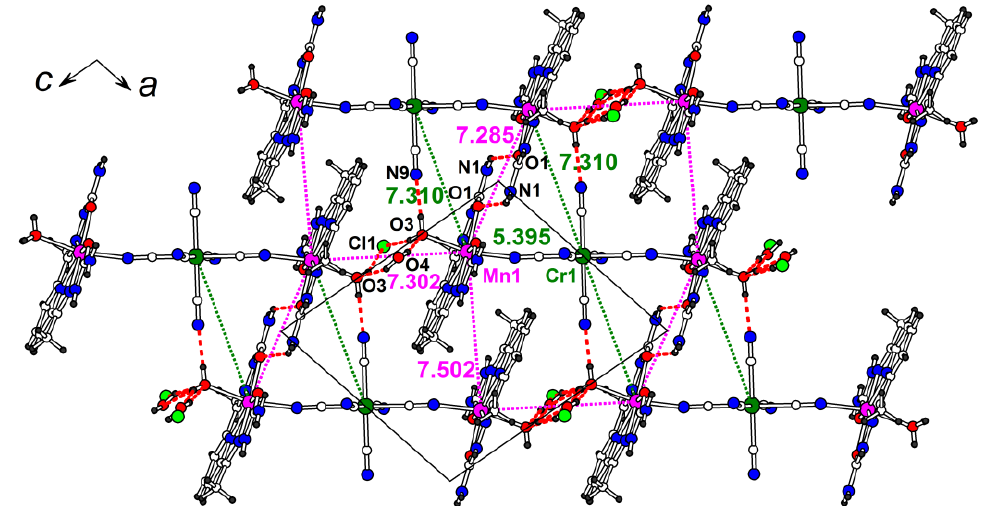
Figure 5. The ac layer in the structure 3 . Intermetallic distances (in Å) are shown (magenta color for Mn…Mn, green color for Mn…Cr). Hydrogen bonds are shown by red dashed lines (see Table S3 for hydrogen bond